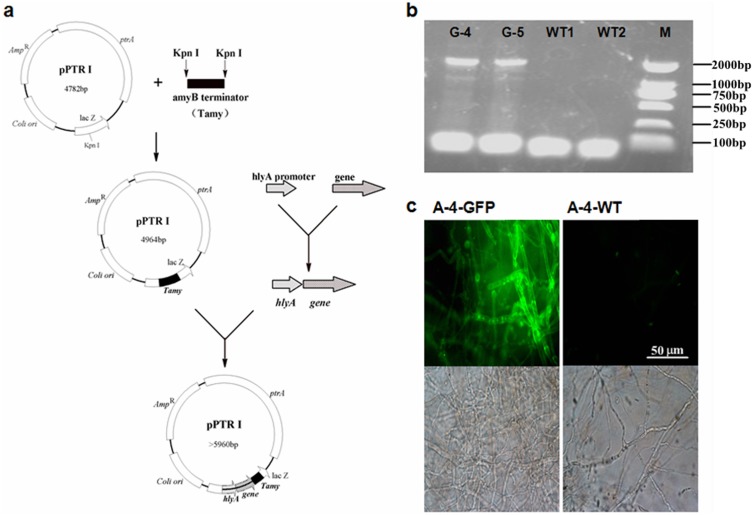
Recombinant strains engineered to express eGFP protein.(A) Construction of the recombinant expression vector for A. oryzae A-4; (B) Isolation of positive transformants by PCR checking; (C) Microscopic observations of mycelium samples exposed to ultraviolet (UV) and white light (WL), which collected from the transformant G-4 (A-4-GFP) and the wild-type A-4 (A-4-WT), respectively.